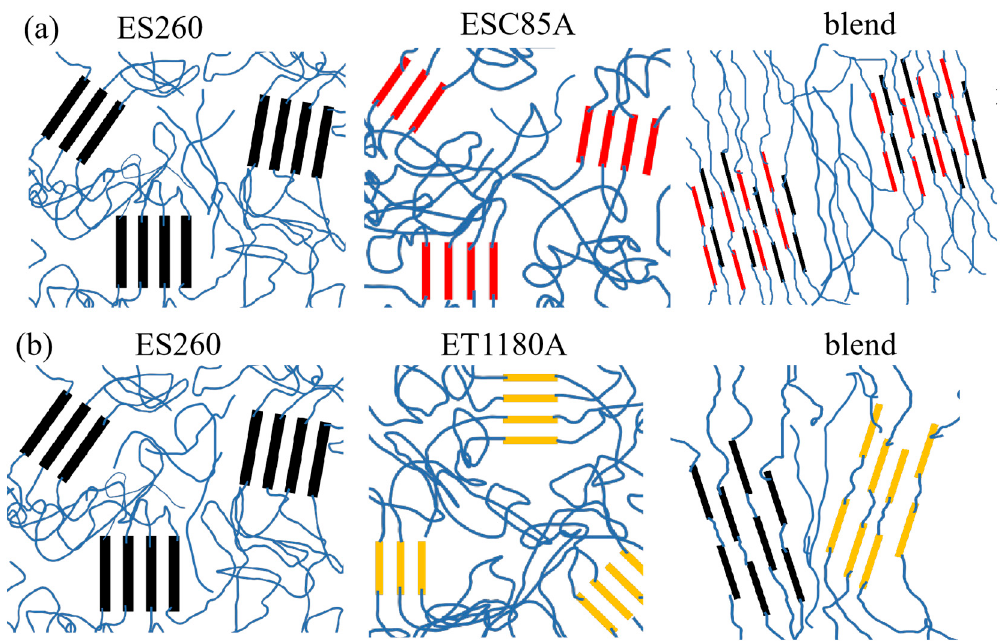
Figure 3. The microstructure and structure evolution of neat TPU and TPU blends. ( a ) ES260 containing TDI with a hard segment content of 33% (black), ESC85A containing MDI with a hard segment content of 33% (red). In the blend system, the aggregation structure of the two kinds of chains rearranges at the molecular level. The hard segment domain of the ESC85A/ES260 blend comprises both ESC85A and ES260 hard segments, forming new phase separation structures with larger phase region distances; ( b ) ES260 containing TDI with a hard segment content of 33% (black), ET1180A containing MDI with a hard segment content of 25% (yellow). A relatively lower compatibility of the hard domains of the ET1180A/ES260 blend, though mutually integrated to some extent, still partly maintain their respective micro domains.